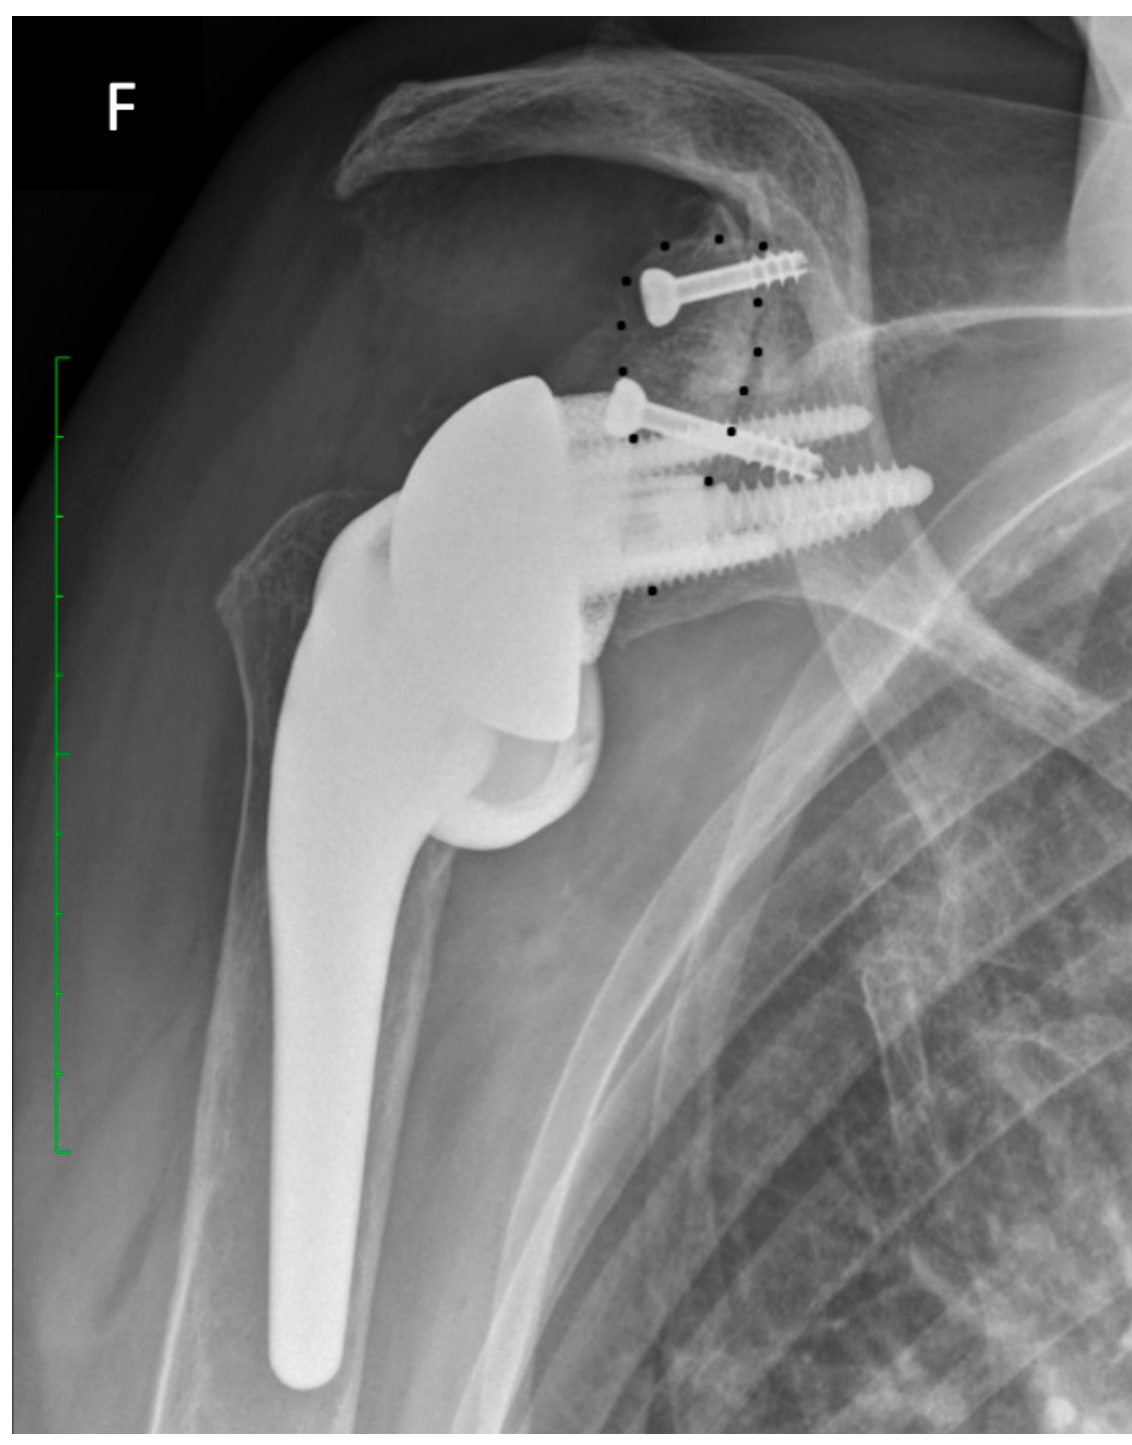
Figure 3. This technique compensates for massive bone defects and creates a more inferior tilt, transforming shear forces into compression ones. ( A ) Sagittal and ( B ) superior views of a 3-dimensional (3D) reconstruction of a right shoulder. Note the massive posterosuperior bone loss. ( C ) Planification reveals that metallic augmentation alone would not achieve optimal joint line restoration. ( D ) Intraoperative anterior view of the paleoglenoid (white asterix) and superior bone erosion (black line). ( E ) Glenoid reconstruction after humeral bone autograft (black arrow). The entire humeral head is hardly sufficient to compensate for the bony erosion. *: paleoglenoid. ( F ) Postoperative anteroposterior X-ray confirms that BMA allows for a large area of bony contact between the autograft (complete humeral head, dotted black line) and the native glenoid, correcting massive bone loss.